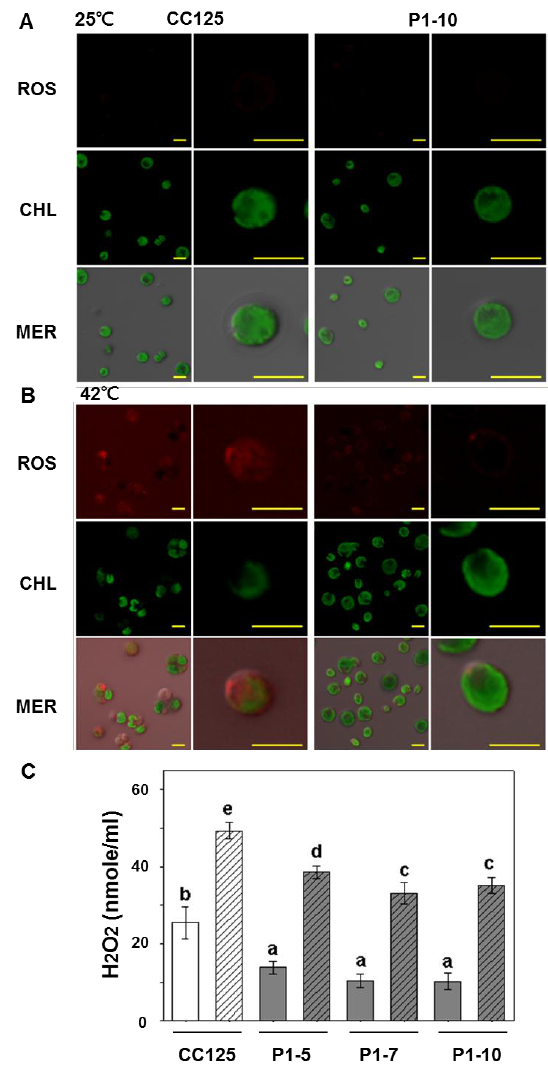
Figure 4. ROS and H O accumulation in Chlamydomonas overexpressing PETF under heat 2 2 treatment. ( A ) ROS accumulation of cells under control treatment; ( B ) ROS accumulation